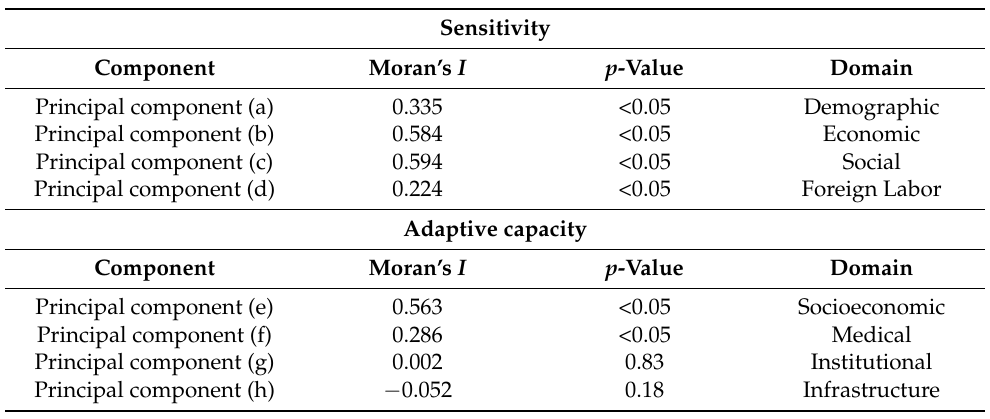
Table 4. Spatial autocorrelation result of the principal